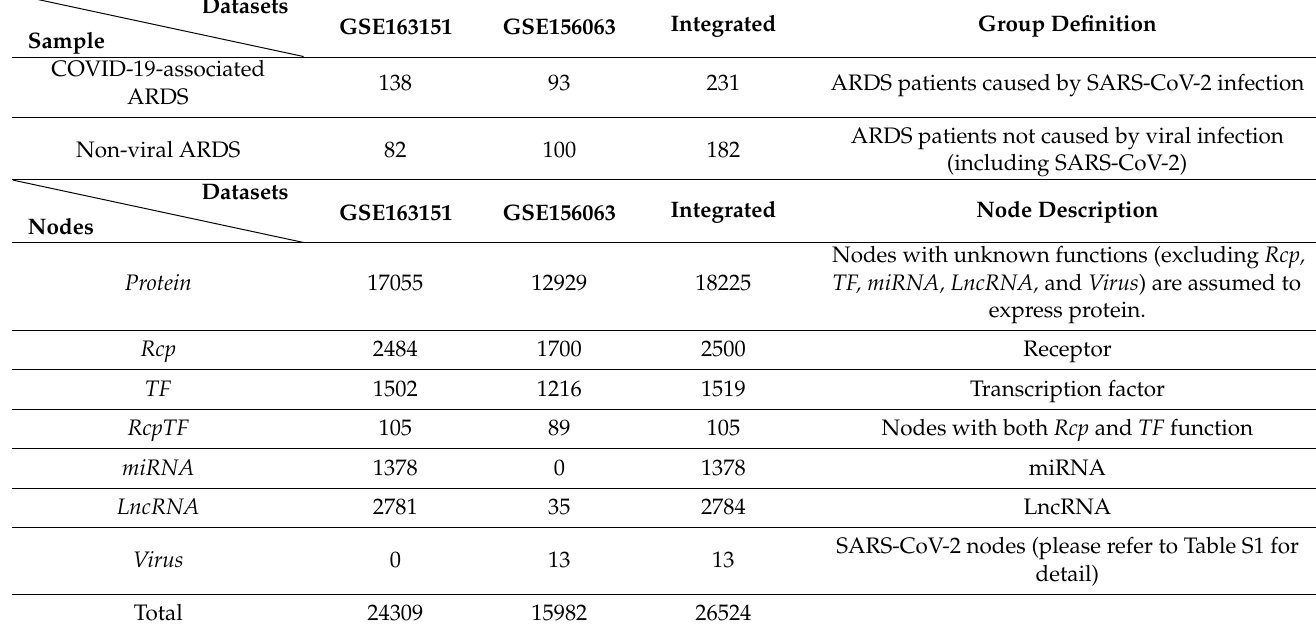
Table 1. Sample groups and statistics of nodes in integrated datasets collected from RNA-Seq datasets of Gene Expression Omnibus (GEO) database (accession nos. GSE156063 and GSE163151).